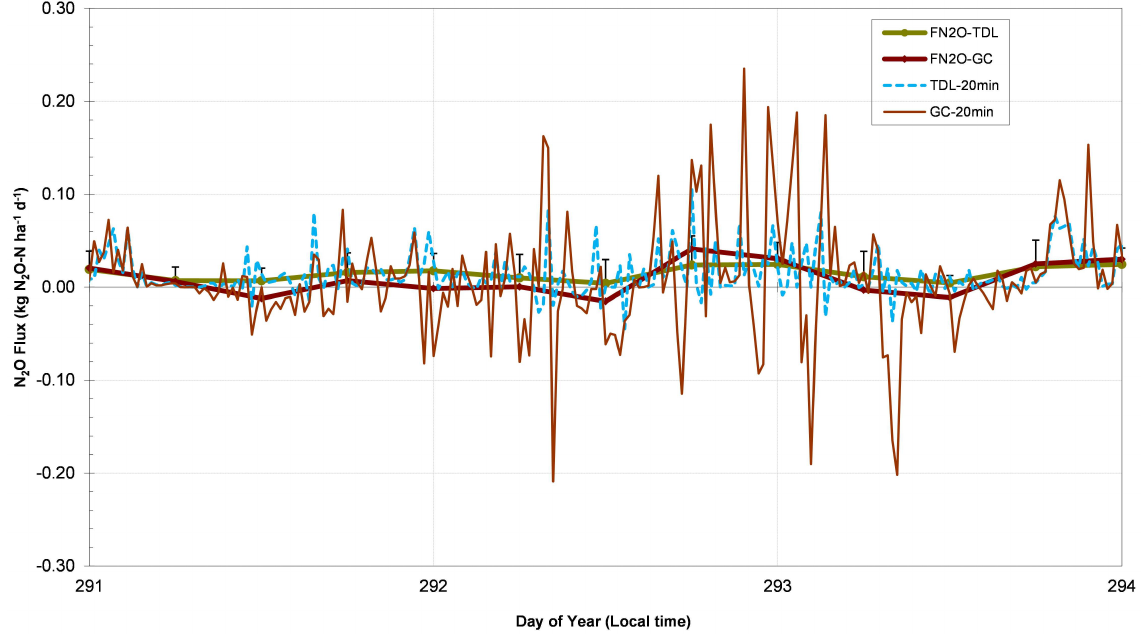
Fig. 7. Comparison of 20min and 6 hourly averaged fluxes from Fig. 6 during a baseline (quiescent) period for